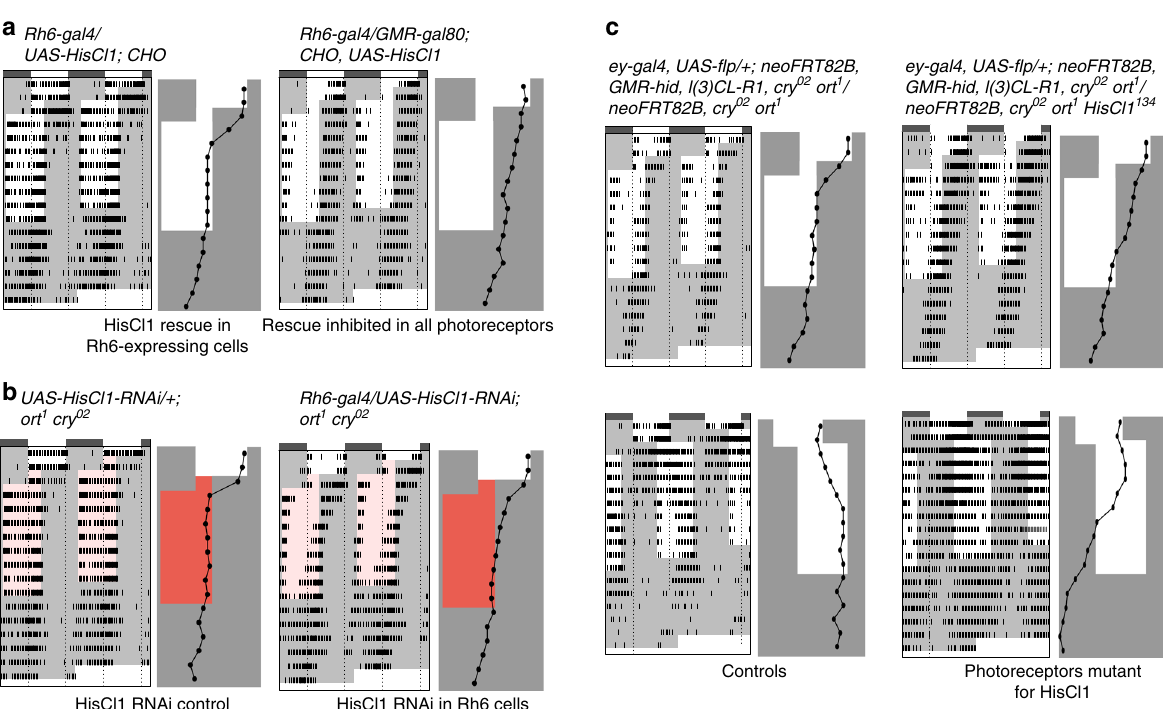
Fig. 4 HisCl1 acts in Rh6-expressing photoreceptors to support circadian entrainment. Actograms and phase plots. The experimental design is as described in Fig. 1 legend for advanced LD/RD cycle ( a , b , c , top). For delayed LD cycles ( c , bottom), the dark phase was lengthened by 8 h between days 2 and 3. a Expression of HisCl1 speci fi cally in Rh6 photoreceptors with a Rh6-gal4 driver rescues entrainment in CHO triple mutants (left). This rescue is blocked by simultaneous expression of Gal80 in all photoreceptors (right). b In the absence of Ort and Cry, RNAi knock-down of HisCl1 in Rh6 photoreceptors slows down the synchronization with advanced RD cycles (right), in comparison to controls (left). c In contrast to control fl ies with HisCl1 + photoreceptors (left), fl ies with HisCl1 134 mutant photoreceptors (right) very poorly synchronize with an advanced LD cycle (top) and fail to synchronize with a delayed LD cycle